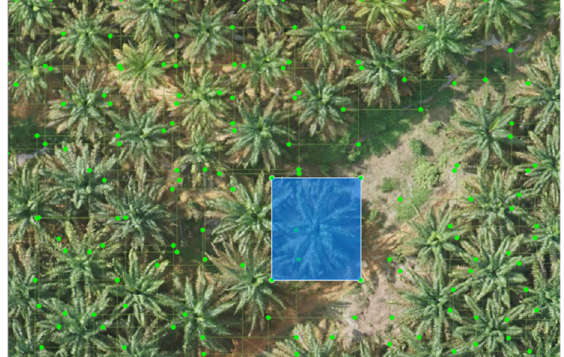
Figure 5. An example of image labeling. Each oil palm tree object is labeled using a bounding box.